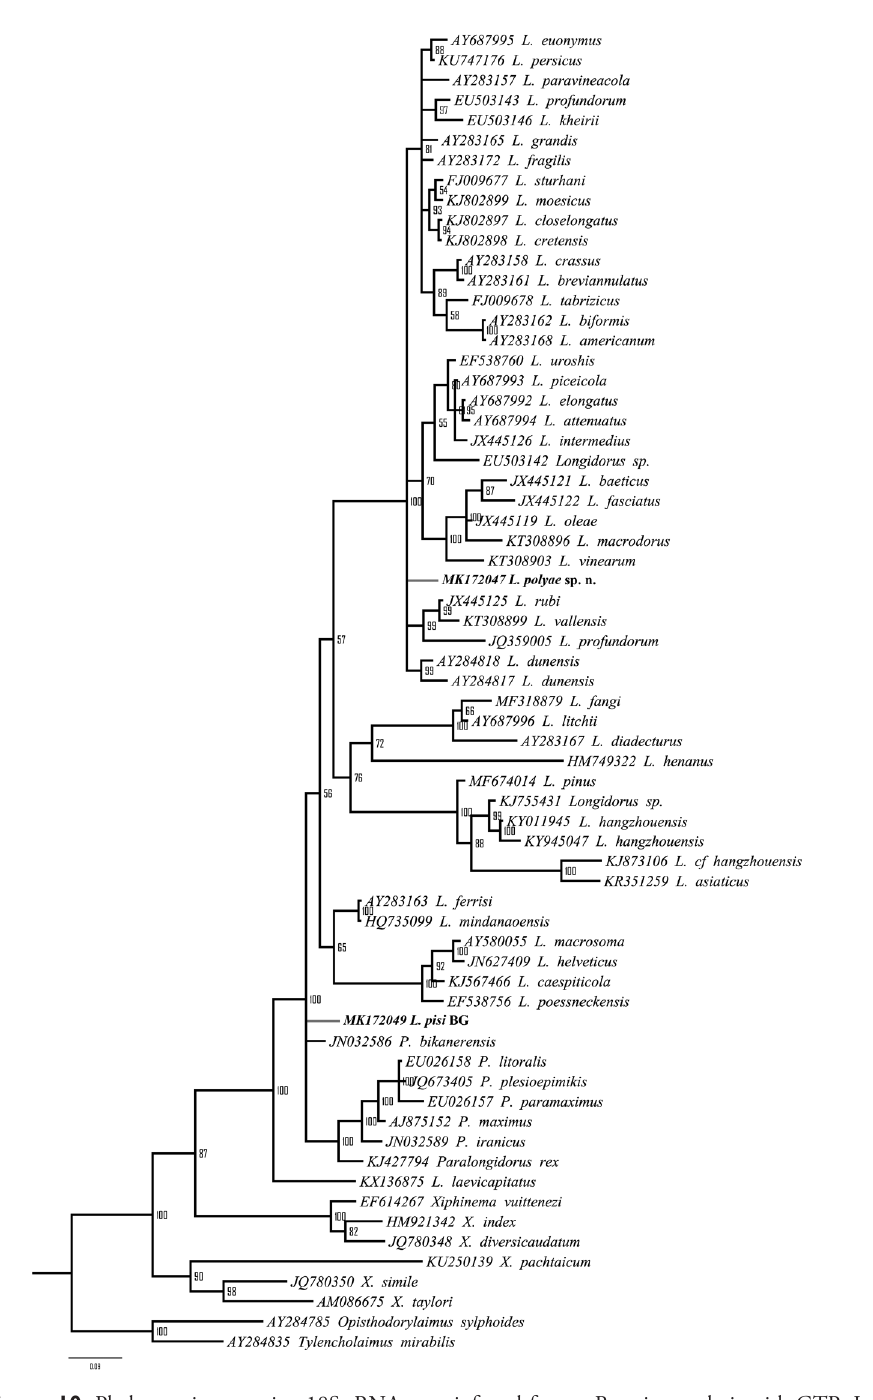
Figure 10. Phylogenetic tree using 18S rRNA gene inferred from a Bayesian analysis with GTR+I+G model. Numbers represent the Bayesian posterior